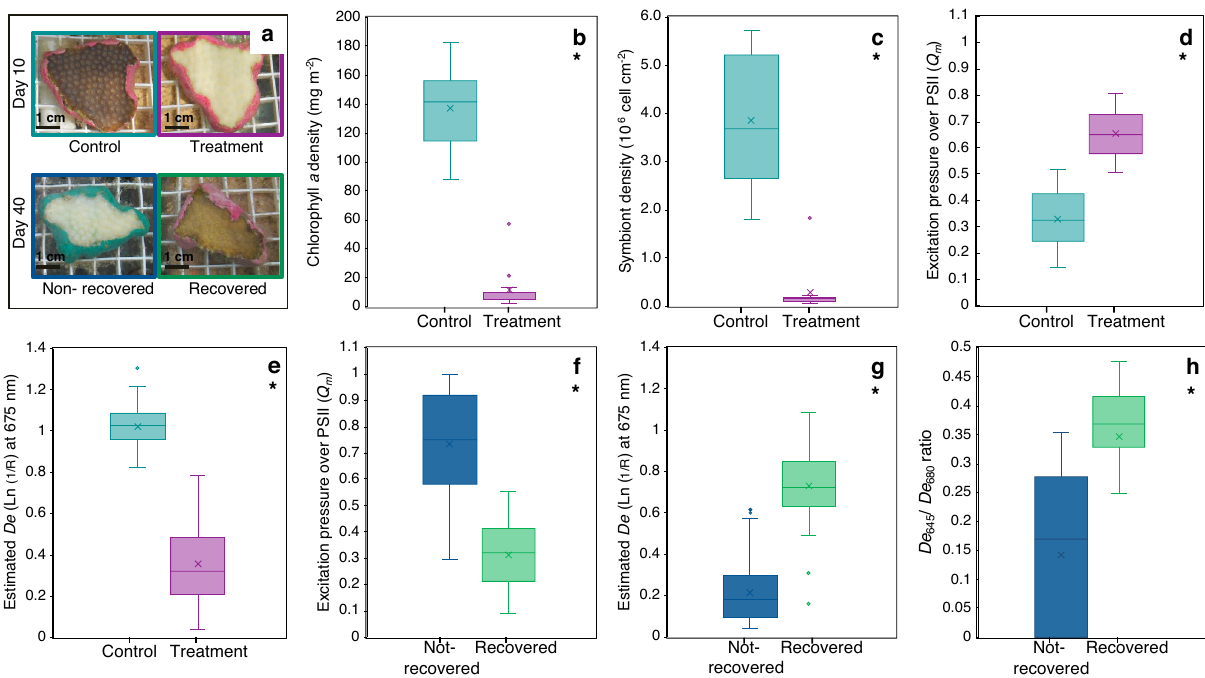
Figure 1. Characterization of the Control and Treatment coral phenotypes . Plot ( a ) illustrates with four photographs the differences on day 10 of the experiment between control and treated coral phenotypes, and differences on day 40 between corals that did recover and did not recover after heat stress ceased. The scale bar in photographs is 1 cm. Box plots for comparison of: ( b ) Chlorophyll a density (n = 11 fragments per group); ( c ) symbiont density (n = 11 fragments per group); ( d ) excitation pressure over PSII (n = 116 fragments per group); and ( e ) estimated absorbance at 675 nm, D e675 (n = 114 fragments per group), between control (light blue) and heat treated (pink) Orbicella faveolata fragments, at the end of heat stress treatment (day 10); Comparation of the ( f ) excitation pressure over PSII (n = 25 fragments per group); and ( g ) estimated absorbance at 675 nm (n = 114 spectra per group), between coral colonies that recovered (green) and did not recover (blue), at the end of the recovery period (day 40); Comparation of the ( h ) 645/680 ratio of the second-derivative analysis of the absorption spectrum (day 10) between coral colonies that recovered (green) and did not recover (blue) (n = 342 spectra per group). Boxes encompass the 25 and 75% quartiles of the variation. The central line corresponds to the median, and bars extend to the 95 and 5% of the confidence limits. Asterisk denotes significant differences among coral groups (T-test, p <